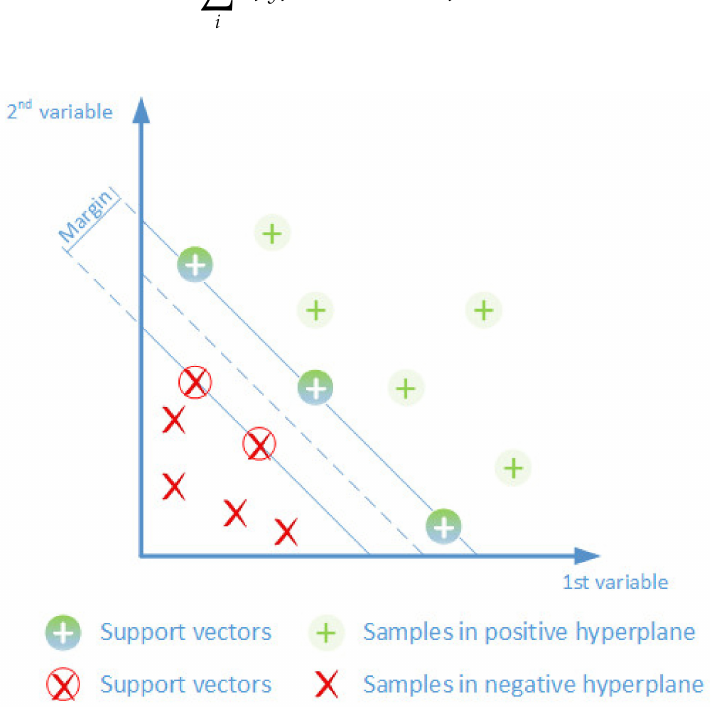
Figure 6. A two-dimensional representation (for clarity) of how support vectors help classify new samples by vicinity in the